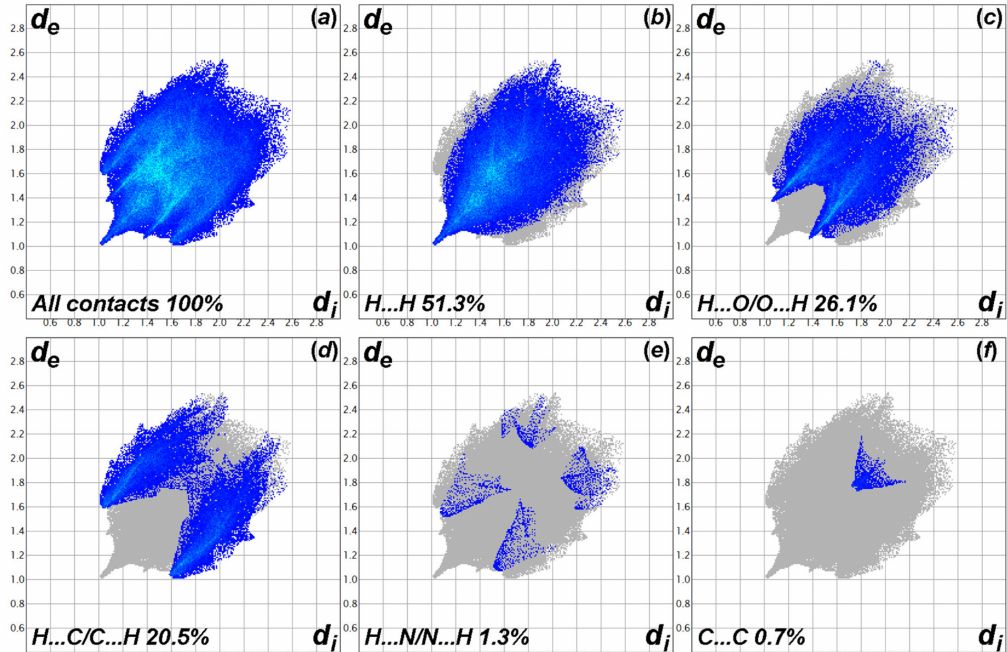
Figure 7. The two-dimensional fingerprint plots for the Ce-MMD complex, showing ( a ) all interactions, and those delineated into ( b ) H · · · H, ( c ) H · · · O/O · · · H, ( d ) H · · · C/C · · · H, ( e ) H · · · N/N · · · H, and ( f ) C · · · C contacts. The d i and d e values are the closest internal and external distances (in Å) from the given points on the Hirshfeld surfaces. The d e + d i values for the H · · · H, H · · · O/O · · · H, H · · · C/C · · · H, H · · · N/N · · · H, and C · · · C contacts are about 2.0, 2.45, 2.6, 2.6, 3.5 Å,